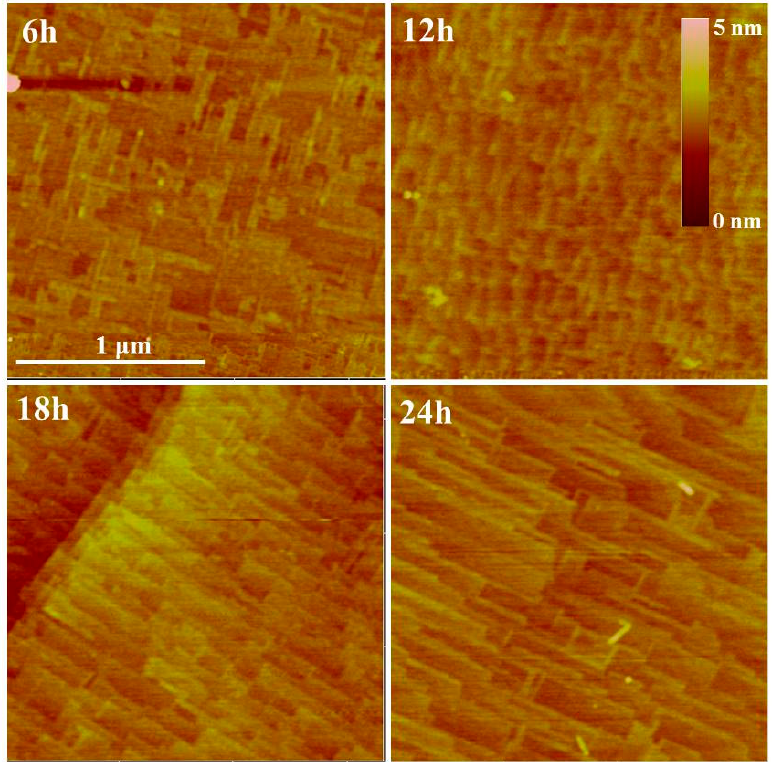
Figure 3. The AFM images of SrTiO 3 single crystals after 6, 12, 18, 24 h annealing.